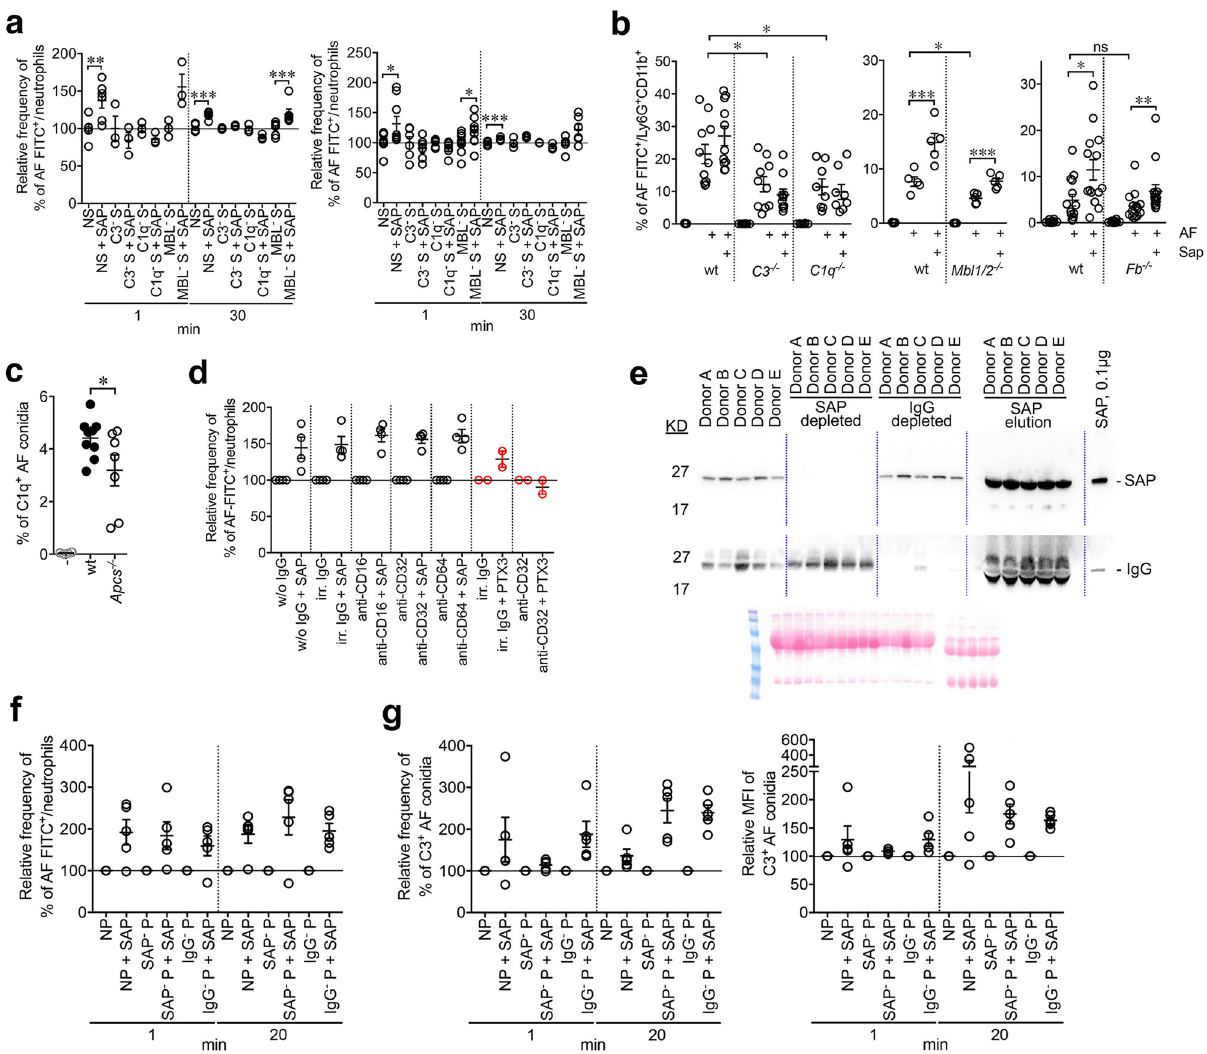
Fig. 3 Initiation of classical complement activation at the bases of SAP-mediated phagocytosis. a FITC-labeled AF conidia (1.6×10 6 ) phagocytosis by freshly isolated human neutrophils (2×10 5 ) in presence of sera depleted ( − ) of complement components and the effect of human SAP opsonisation after 1 and 30min. AF conidia (2×10 8 ) opsonisation with 100 µ g of human native SAP. Five percent (left) or 10% (right) of human sera were used. Mean±SEM of two experiments performed in triplicate and merged. Each spot corresponds to a replicate. Left, NS vs. NS + SAP, ** P = 0.009; *** P = 0.002. MBL − S vs. MBL − S + SAP, *** P = 0.002 (two tailed, Mann – Whitney U -test). Right, NS vs. NS + SAP, * P = 0.01; *** P = 0.002. MBL - S vs. MBL - S + SAP, * P = 0.04 (two tailed, Mann – Whitney U -test). b FACS analysis of phagocytosis of FITC-labeled AF conidia (5×10 6 /200 µ l of blood; 20min) opsonized or not with murine SAP in whole blood of wt, C3-, C1q-, MBL1/2-, and Factor B-de fi cient mice. Each fi gure refers to independent experiments performed. Results of C3 − / − , C1q − / − , and Mbl1/2 − / − are mean±SEM of one experiment, whereas for Fb − / − two experiments were merged. Correspondent wt littermates were used as control for C1q-, MBL1/2- (C57BL/6J) and Factor B-de fi cient mice (C57BL6/NJ). Each spot represents a single mouse. Left, n = 11 wt, n = 10 C3 − / − , n = 8 C1q − / − . wt vs. C3 − / − , * P = 0.02; wt vs. C1q − / − , * P = 0.02 (two-sided, unpaired t -test). Middle, n = 5 wt, n = 5 Mbl1/2 − / − . wt vs. Mbl1/2 − / − , * P = 0.01; wt vs. wt + Sap, *** P = 0.004; Mbl1/2 − / − vs. Mbl1/2 − / − + Sap, *** P = 0.002 (two-sided, unpaired t -test). Right, n = 12 wt, n = 14 Fb − / − . wt vs. wt + Sap, * P = 0.02 (two-sided, unpaired t -test); Fb − / − vs. Fb − / − + Sap, ** P = 0.005 (two tailed, Mann – Whitney U -test). c FACS analysis of C1q deposition on AF conidia (1×10 7 ) in presence of plasma from wt ( n = 9) or Apcs − / − ( n = 7) mice. Mean±SEM; * P = 0.05 (two-sided, unpaired t -test). d Effect of blocking of Fc γ receptors in SAP-mediated phagocytosis. Human SAP-pre-opsonized FITC-labeled AF conidia (1.6×10 6 ) phagocytosis by freshly isolated human neutrophils (2×10 5 ; 5min) in presence of NS and anti-CD16, anti-CD32, anti-CD64 or an irrelevant mouse IgG1 (all used at 10 µ g/ml). Each spot corresponds to a single healthy donor ( n = 4) performed in duplicate. Mean±SEM. e – g Effect of IgG depletion in SAP-mediated phagocytosis ( f ) and complement deposition ( g ). e Western blot analysis for SAP and IgGs in human plasma and after their depletion. 1 µ l/lane of plasma-heparin from fi ve healthy donors (A – E) and 10 µ g/lane of proteins eluted from the anti-SAP column were loaded. Ponceau red staining was shown. Human SAP (0.1 µ g/lane) was used as control. f FACS analysis of phagocytosis by neutrophils (2×10 5 ) isolated from A – E donors after challenge with FITC-labeled AF conidia (1.6×10 6 ) opsonized or not with human SAP (100 µ g/1×10 9 conidia/ml) in the presence of autologous plasma-heparin (10%) depleted of SAP (SAP - ) and IgGs (IgG - ). g C3 deposition on AF conidia (1×10 7 ) opsonized or not with human SAP. SAP- and IgG-depleted plasma-heparin (10%) from A – E donors were used. f , g Each spot refers to mean of a duplicate per donor.